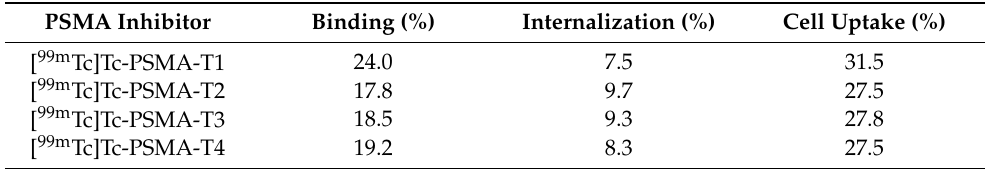
Table 3. Binding, internalization, and cell uptake of PSMA inhibitors.